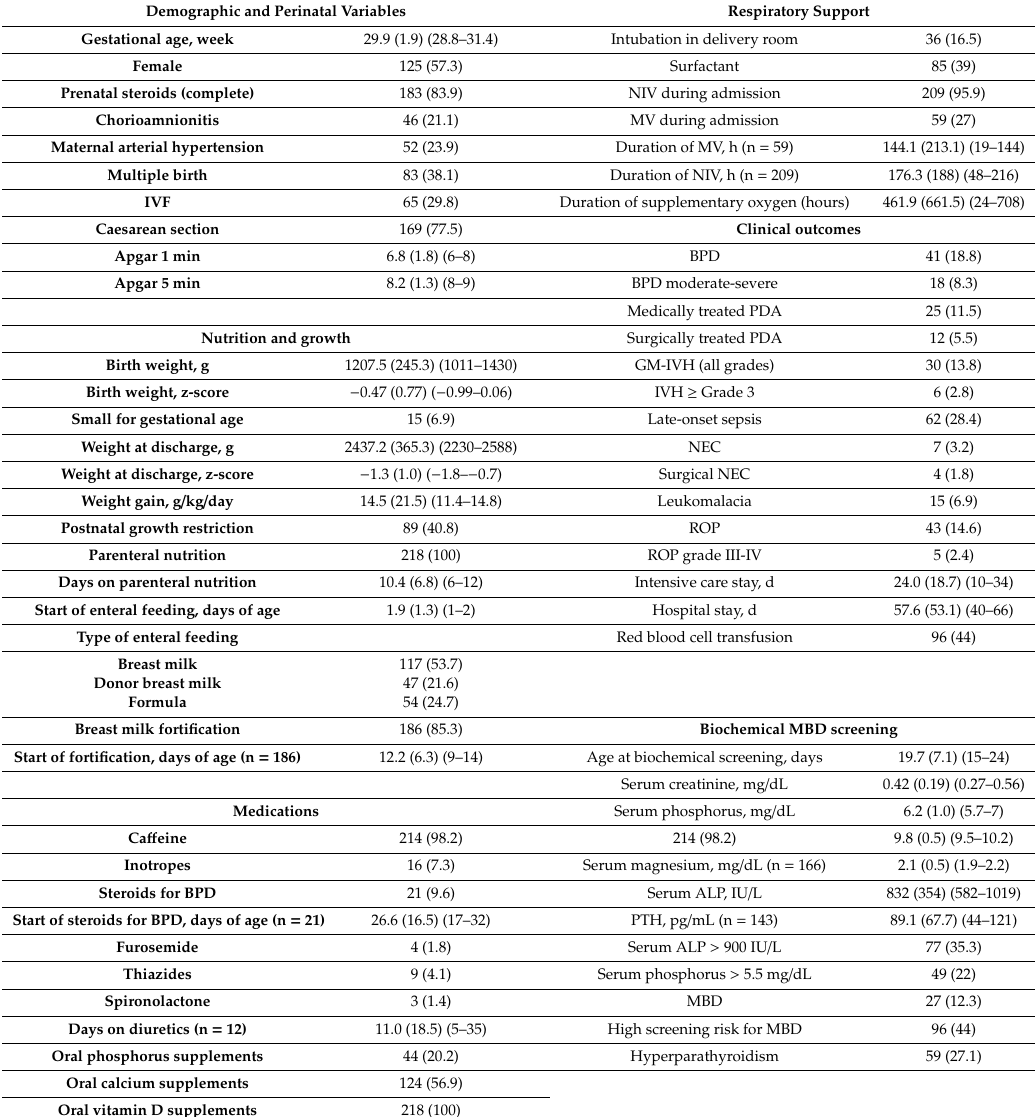
Table 1. Characteristics of the study population.